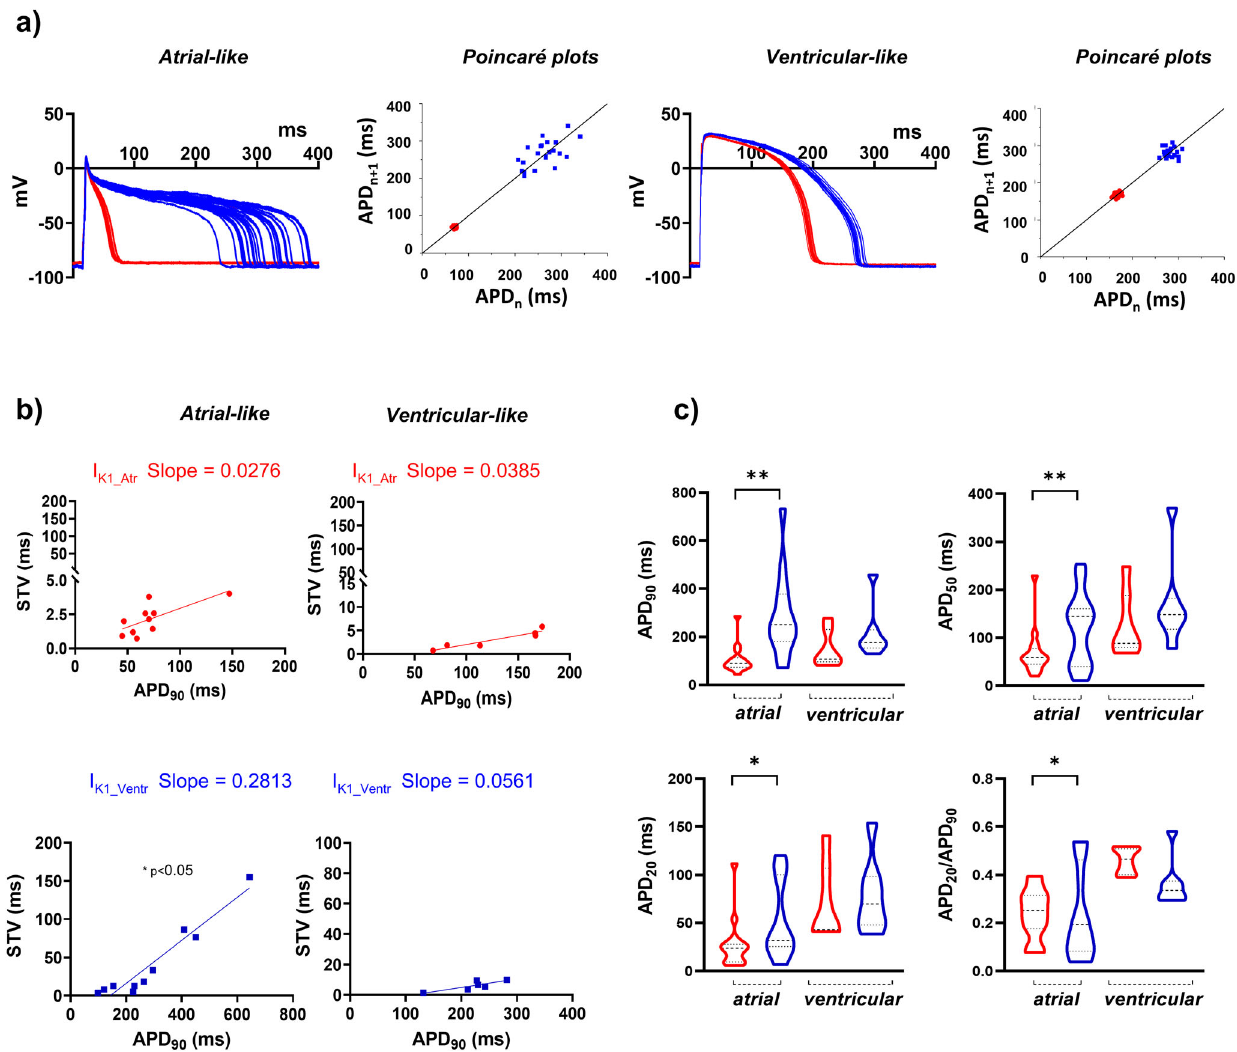
Fig. 6 I K1_Ventr vs I K1_Atr application and repolarization stability. a A series of 30 APs recorded under the injection of I K1_Atr or I K1_Ventr computational model either in atrial- or ventricular-like CMs. In parallel, the dispersion of relative APD 90 values is plotted around the identity line in Poincaré plots. b Linear STV/APD 90 correlations in each condition, resulting signi fi cantly higher with I K1_Ventr vs I K1_Atr model in atrial- and ventricular-like CMs ( n = 10 and n = 5 cells respectively, from 4 independent differentiations) (* p < 0.05 paired t -test RA vs Std). c Variance comparison of atrial and ventricular ( n = 16 and n = 7 cells respectively, from 2 independent differentiations) electrical biomarkers under the injection of two I K1 models, showed as violin graphs. (APD 90 , APD 50 , APD 20 , AP duration measured at 90, 50 and 20% of the repolarisation phase; APD 20 /APD 90 ratio; I K1_Ventr , ventricular I K1 equation; I K1_Atr , atrial I K1 equation; STV, short-term variability). Levene ’ s test was used to quantify the equality of variance in triangulation parameters (* p < 0.05; ** p <